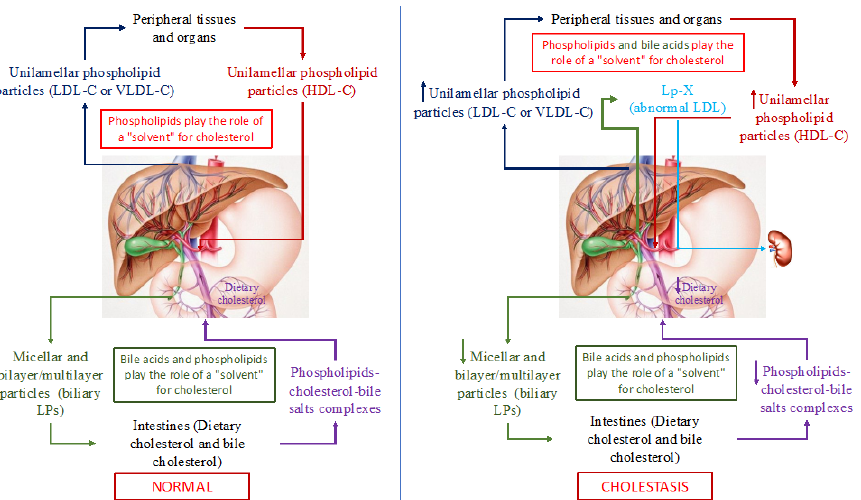
Figure 2. Schematic representation of cholesterol transport in the human body in normal (left part of the picture) and with cholestasis (right part of the picture). Note: LP(s)-lipoprotein(s); LDL-C—low-density lipoproteins cholesterol; VLDL- С —very low-density lipoproteins cholesterol; HDL-C—high-density lipoproteins cholesterol; Lp-X—lipoprotein X.